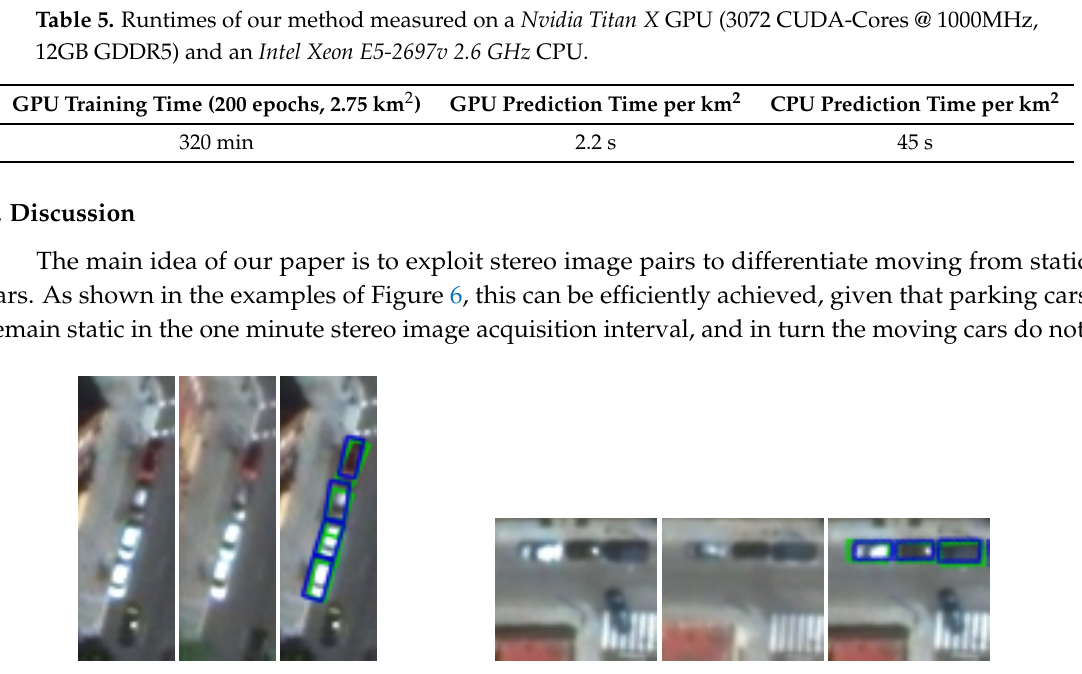
Table 5. Runtimes of our method measured on a Nvidia Titan X GPU (3072 CUDA-Cores @ 1000MHz,